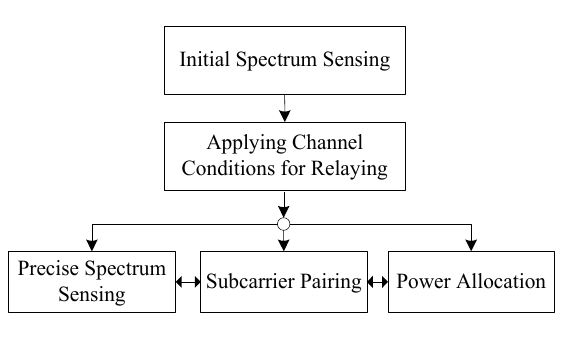
Figure 2. Flowchart of the proposed